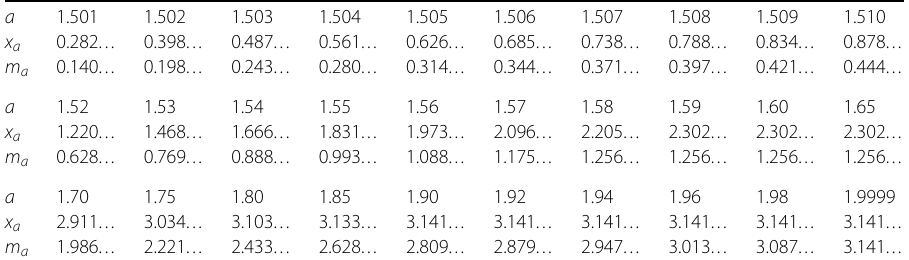
,2) related to Theorems 6 and 10, 2